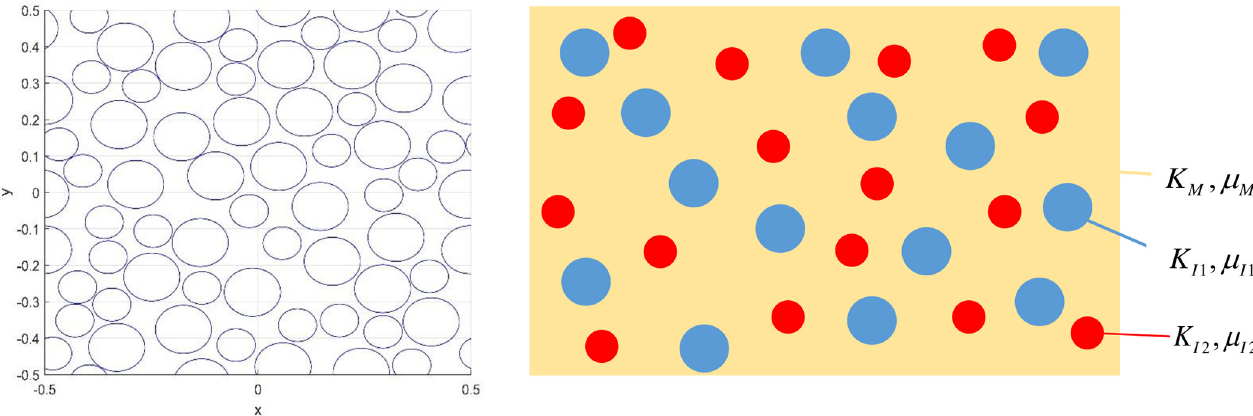
Fig. 1. Unit cell containing 60 circle-inclusion randomly palaced (left), three phase model of composite with two different circles inclusion (right).